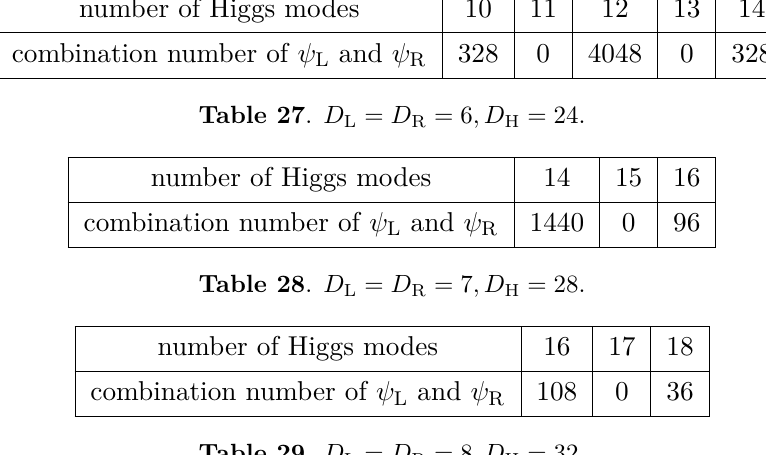
Table 28 . D L = D R = 7 , D H = 28 .